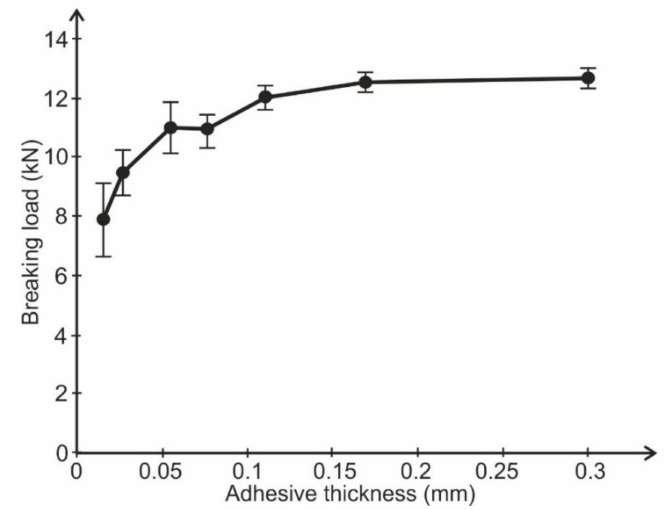
Figure 6. Dependence of lap joint strength on adhesive thickness (Araldite AW136H